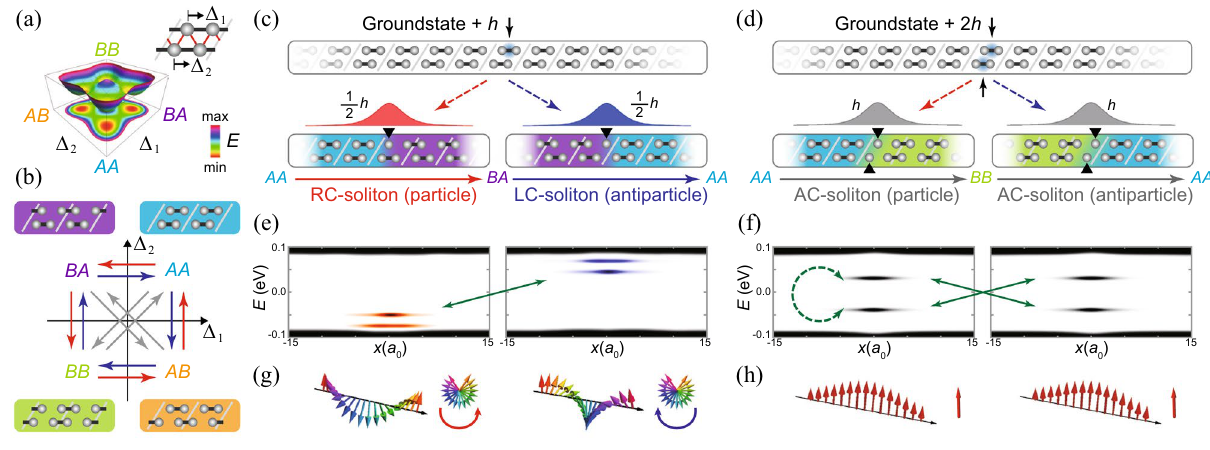
Figure 1. Particle-antiparticle (PA) duality of topological solitons in the double-Peierls-chain model. (a) Total energy (left diagram) of double-Peierls-chain model (right diagram) as a function of order parameters (cid:31) i ( i = 1, 2 ), where (cid:31) i is the atomic dimerization displacement of the i -th chain. The model is composed of four atoms in a unit cell with interchain coupling (red lines). ( b ) Atomic configurations of four groundstates and 12 solitons (interpolating two of groundstates) in the order-parameter space. Right-chiral (RC), left-chiral (LC), and achiral (AC) solitons are represented by red, blue, and gray arrows, respectively. ( c , d ) Pair-creation of ( c ) chiral and ( d ) achiral solitons by adding a hole h or two holes 2 h to a groundstate. Below each soliton profile, the corresponding atomic configuration is demonstrated and black triangles show soliton centers (unpaired atoms or kink positions). ( e , f ) Spatially resolved local densities of states (LDOS’s) of ( e ) RC-, LC-, and ( f ) AC-solitons. In each energy gap, RC-, LC-, and AC-subsoliton states are represented by red, blue, and gray colors. Solid green arrows indicate the PA partners ( e ) between RC- and LC-subsoliton states and ( f ) between AC-subsoliton states. Dashed green arrow represent that each AC-subsoliton is its own PA partner. ( g , h ) Spatial distribution of pseudospin vectors of ( g ) RC-, LC-, and ( h ) AC-solitons along the chain. Pseudospin vectors of RC- and LC-subsolitons rotate oppositely along the chain while those of AC-subsolitons do not